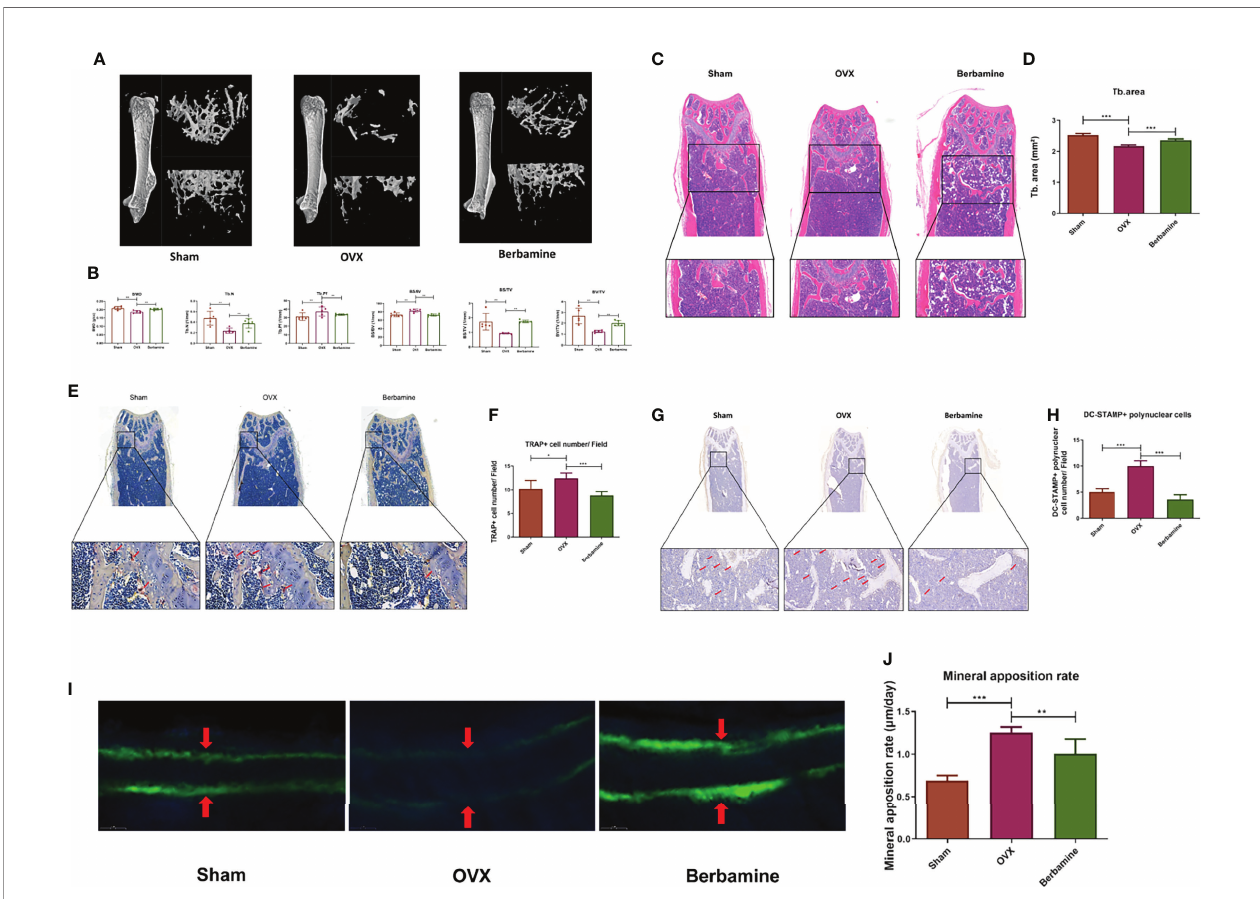
FIGURE 5 | Berbamine can prevent boneloss by inhibiting osteoclast differentiation and osteoclastboneresorption function invivo . (A) 3D reconstruction images of the distalfemursofmicein the sham, OVX and berbamine groups are presented. (B) The BMD,Tb.N, Tb.Pf, BS/BV, BS/TV, and BV/TV values of the distalfemursofthe mice in the sham,OVX andberbamine groupsare presented. (C) The hematoxylin-eosin staining of bone trabeculae inthe metaphyses of the distal femursof the mice ineach group was quanti fi ed via ImageJ. (D) Quanti fi cation ofthe area of bone trabeculain distal femursof mice inthree groups, respectively. (E) TRAP immunohistochemical staining of distalfemursofmicein three groups, respectively, the red arrows point to TRAP-positive cells in the metaphysis of the distalfemur. (F) Quanti fi cation of TRAP-positive cells in the metaphyses of the distalfemurs ofthe mice in the three groups. (G) DC-STAMP immunohistochemical staining of distal femurs of mice inthree groups, respectively,the redarrows point to DC-STAMP-positive cells in the metaphysisof the distal femur. (H) Quanti fi cation ofDC-STAMP-positive cells in the metaphyses of the distalfemursof the mice inthe three groups. (I) Calcein double labelingfor measurement offemoral bone formation in mice inthe sham,OVX,and berbamine groups. (J) Quanti fi cation of the MARs in the femursof the mice in thesham,OVX andberbamine groups. The data are presentedas the mean ± SD,*P < 0.05; **P < 0.01; ***P <